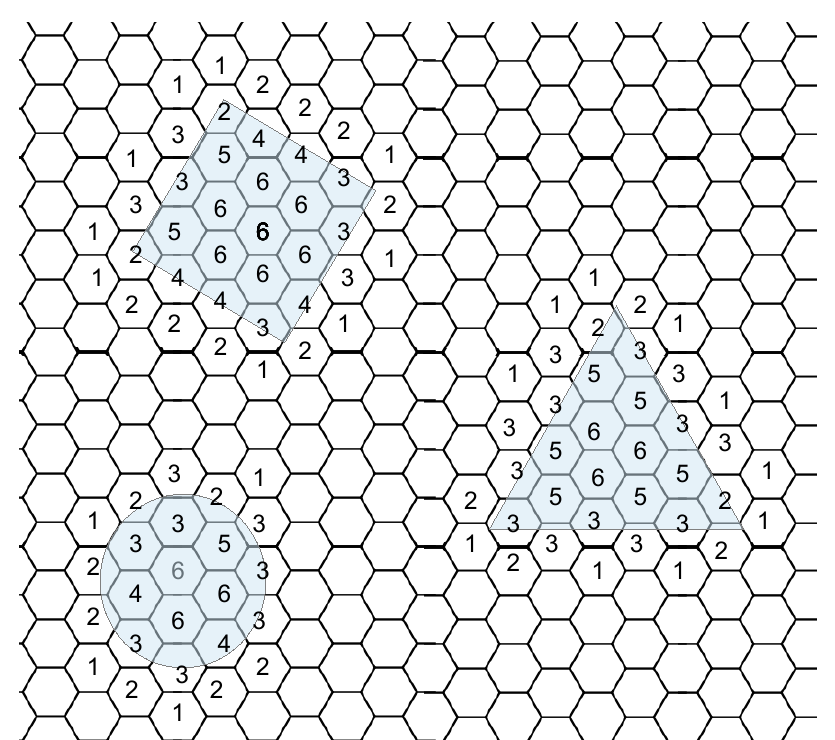
Figure 11. Cells nearby objects and under the objects display a number of neighbors covered by an object. The shapes are shown by the blue transparent boxes and the numbers indicate how many local neighbours are